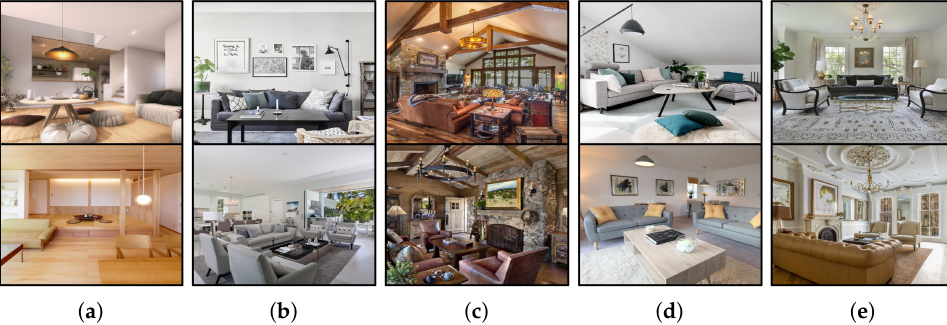
Figure 4. Examples of the image dataset. ( a ) Japanese. ( b ) Modern. ( c ) Rustic. ( d ) Scandinavian. ( e )